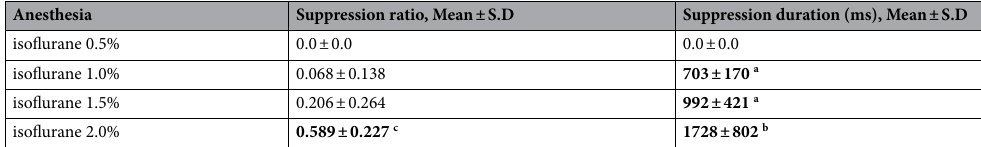
Table 1. Burst-suppression characteristics were observed under anesthesia with isoflurane (1.0% or higher) but not with α-chloralose. Suppression periods were defined as periods in which LFP fluctuations were less than 0.1 mV/ms for a period of 500 ms or longer, while suppression ratio is the ratio of total suppression period to total recording time. (n = 8). a p < 0.01 for isoflurane 1.0% > isoflurane 0.5% and